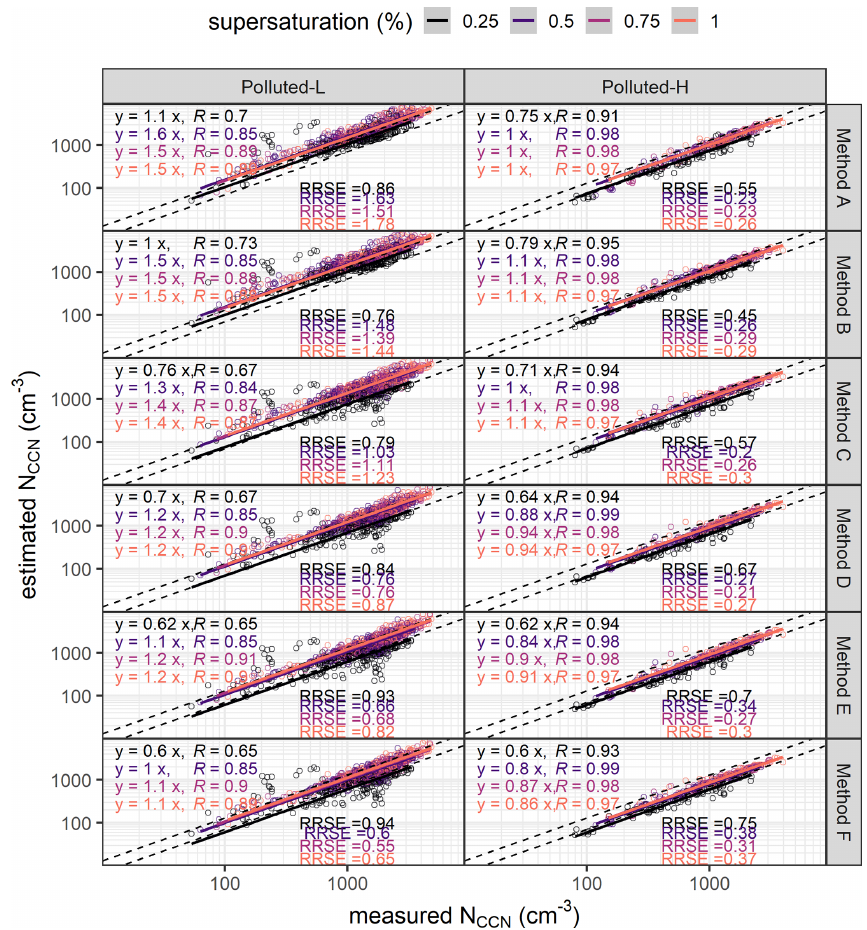
Figure 5. Comparison of measured N CCN against estimated N CCN under different SS using each method in Polluted- L and Polluted- H . The colour codes representing SS, equation of regression line, Pearson correlation efficient and relative root square error (RRSE) are shown in each panel. The dashed lines represent 30% uncertainty ranges. Note that axes are in logarithmic